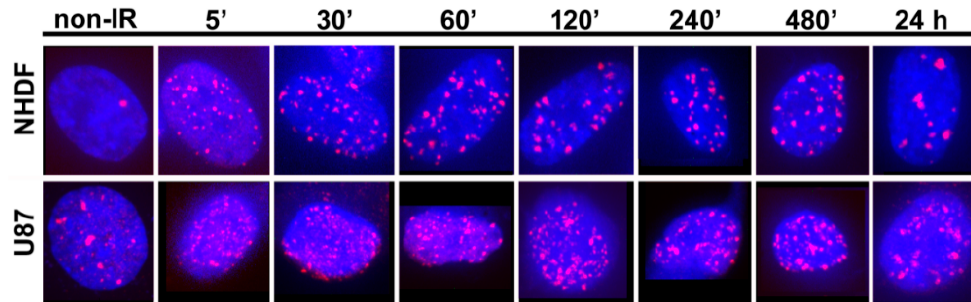
Figure 1. 2D maximum intensity projection images of confocal image stacks. Typical examples are shown for fluorescently-labeled 53BP1 foci in NHDF cells and U87 cells after 4 Gy 15 N-irradiation in 90°-geometry. Along the given time line, samples were taken as aliquots of the same culture at different time points (5 min, 30 min, 60 min, 2 h, 4 h, 8 h and 24 h) after irradiation. All timelines were repeated with independent cultures. For comparison, examples of non-irradiated cells are also presented.